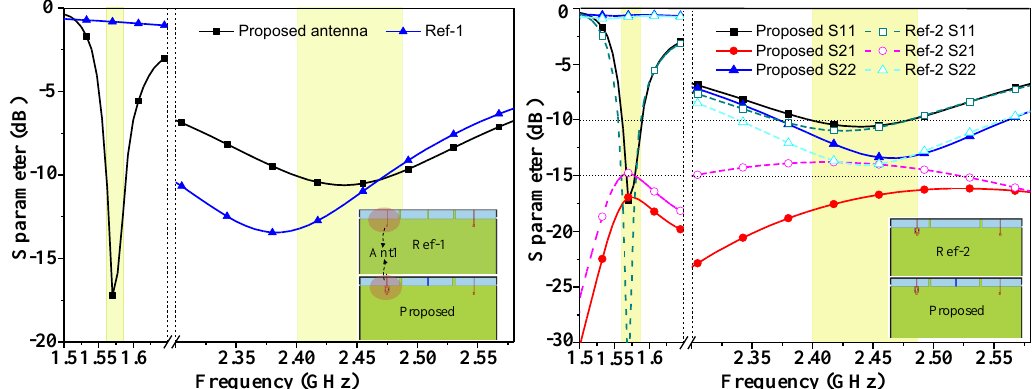
Figure 2. Simulated S parameter of Ant1 for the proposed antenna with and without ( a ) the matching network (Ref-1) and ( b ) the middle shorting strip (Ref-2).